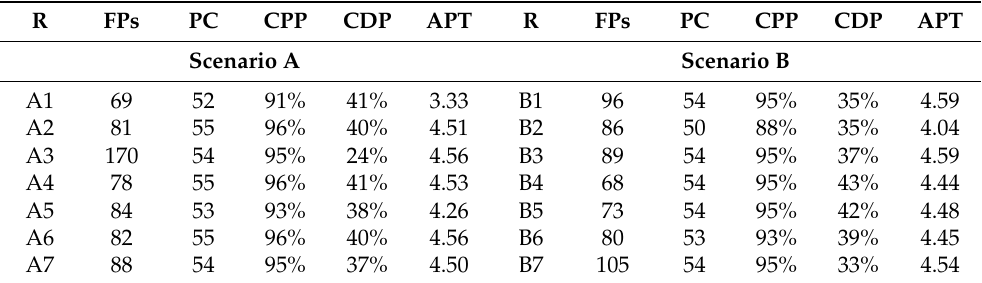
Table 8. Five MS results. Legend: R—Run; FPs—False Positives; PC—Predicted Collisions; CPP— Collision Prediction Percentage; CDP—Correct Decision Percentage; APT—Average Prediction Time (s).